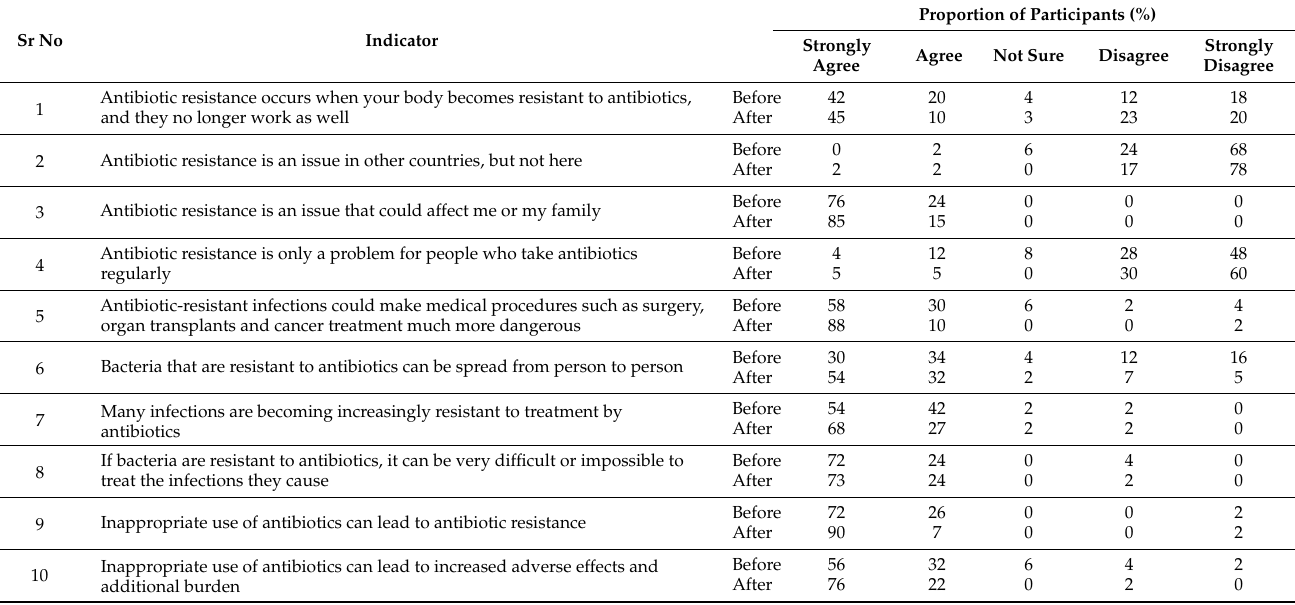
Table 4. Awareness of health professionals of